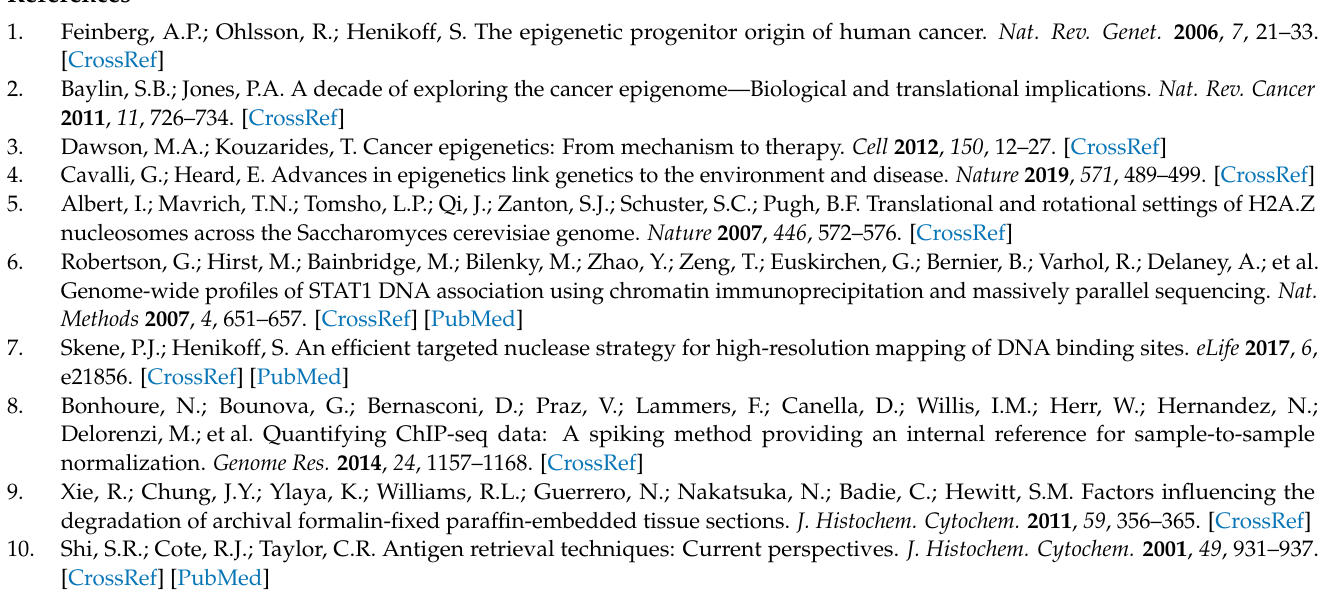
regions, Figure S10: The majority of DERs are properly grouped, Table S1: Sample characteristics, antibody information, and ChIP-seq library statistics, Table S2: Clinical information of LUAD in this study, Table S3: The list of annotated DERs for H3K27ac ChIP-seq in LUADs (|log2 FC| > 2, FDR < 5 × 10 − 4 , n = 2128), Table S4: The list of KEGG pathways associated with annotated